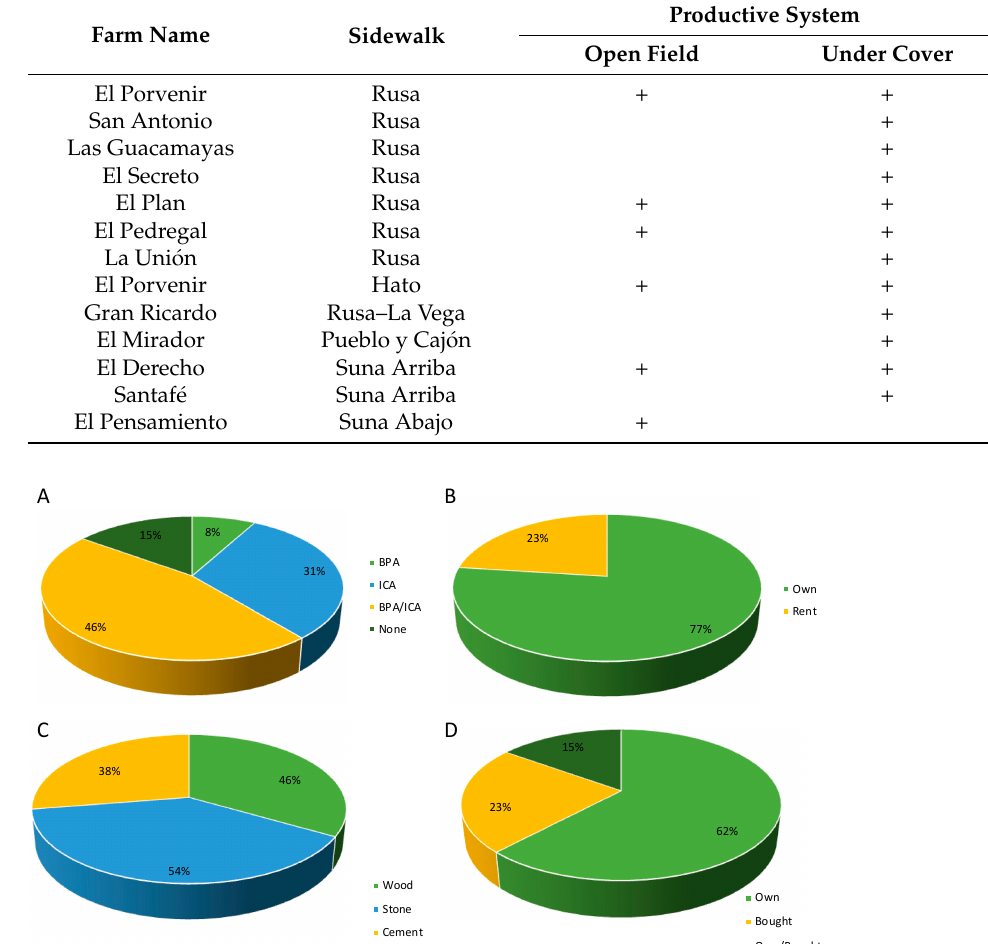
Table 4. Farms registered and evaluated in the municipality of Miraflores, Boyac á .